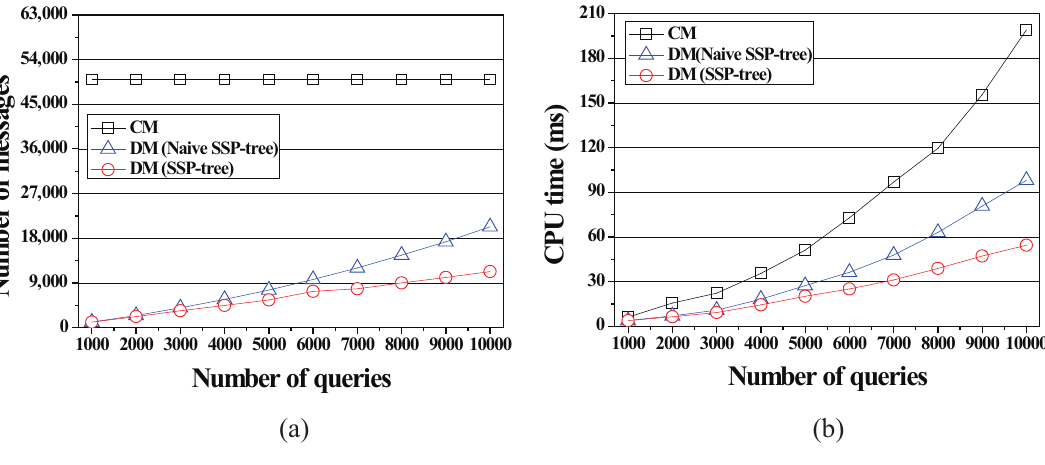
Figure 7. Effect of the number of queries on the communication cost and the server computation cost. ( a ) Total number of messages vs. the number of queries; ( b ) The amount of CPU-time vs. the number of